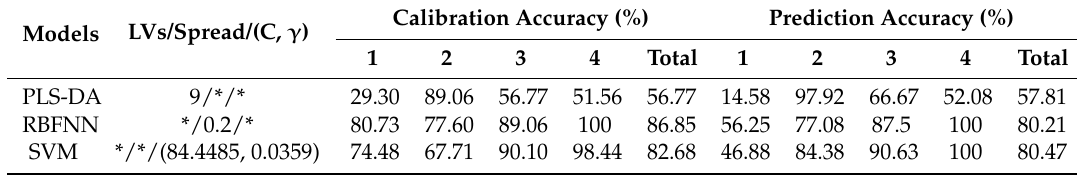
Table 3. The results of the PLS-DA, RBFNN and SVM models on selected wavelength variables.